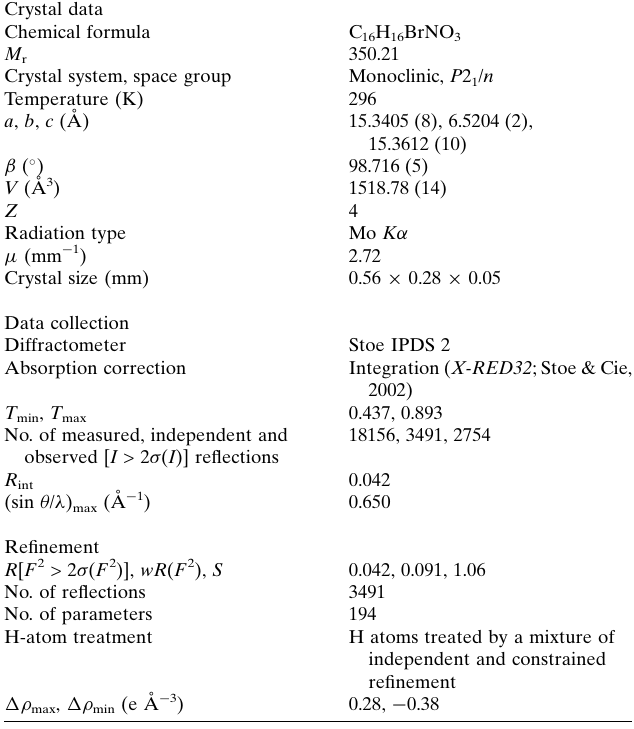
Crystal data Chemical formula